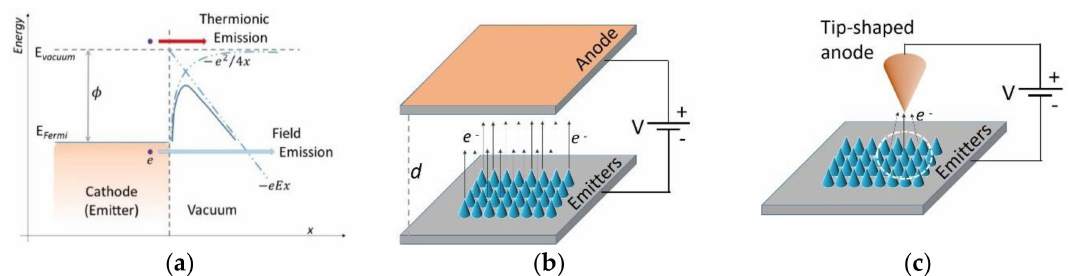
Figure 1. ( a ) Potential energy of the electron as function of the distance x from the metal-vacuum interface. The barrier for electron field emission is thinned and lowered by the electric field and the image force, which add to φ the position-dependent terms − eEx and − e 2 /4 x , respectively. Experimental setup for field emission measurements in the ( b ) parallel plate and ( c ) tip configuration for average and local characterization,